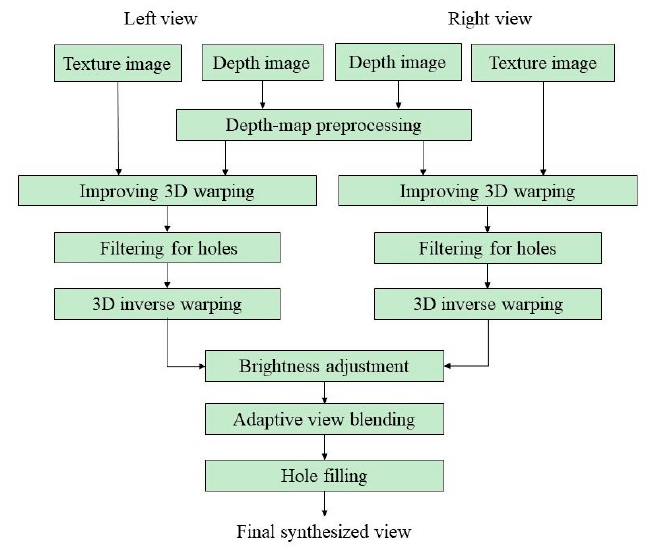
Figure 4. Flowchart of the proposed system.